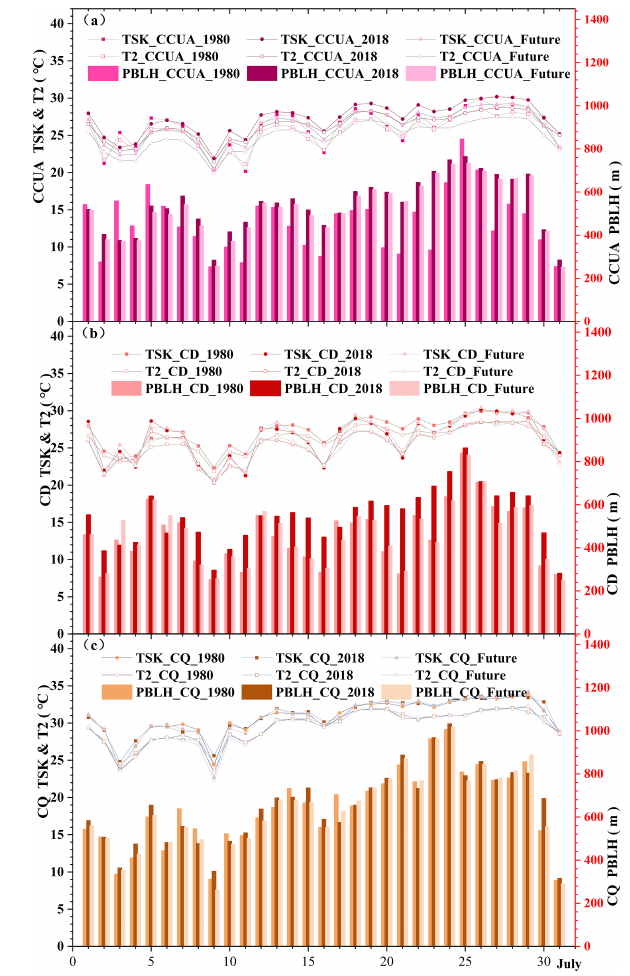
Figure 10. (a) The TSK and T 2 trends and PBLH distribution over the Chengdu–Chongqing urban agglomeration. (b) The TSK and T 2 trends and PBLH distribution over Chengdu. (c) The TSK and T 2 trends and PBLH distribution over Chongqing. (“Trends” means the daily average change in TSK, T and PBLH. The unit of TSK and T is degrees Celsius; the coordinate axis is on the left. The unit of PBLH is meter (m), and the coordinate axis is on the